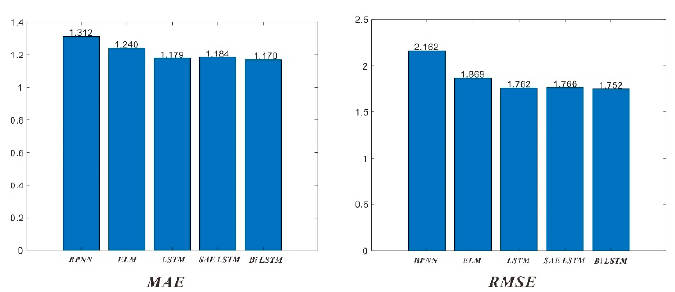
Figure 15. The test set performance of five prediction models for temperature prediction.